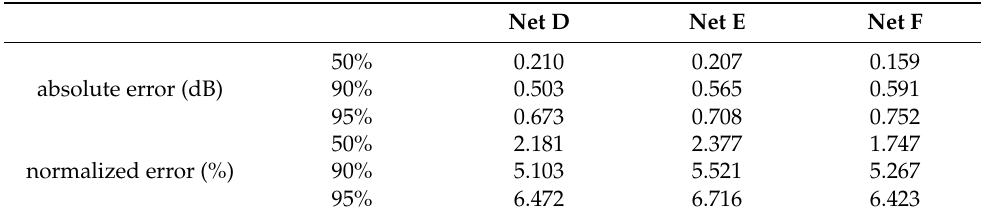
Table 3. CNN performance of correlation distance extraction.